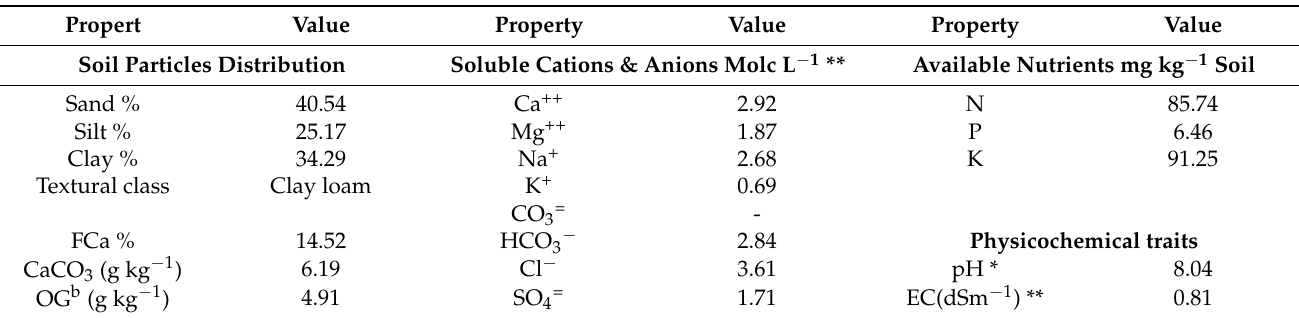
Table 7. Physicochemical properties of the investigated soil; soil particle distribution, soluble cations and anions, available nutrients and some physicochemical